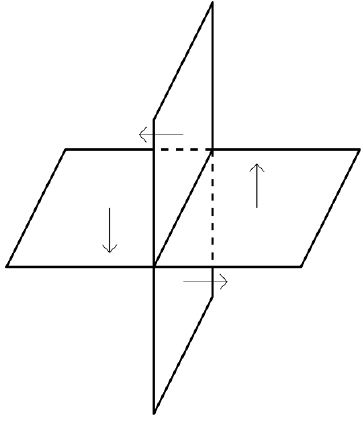
Figure 1 . The local generator of the gauge transformations. The E s are added up on all four plaquettes adjoining a link with orientations given by the